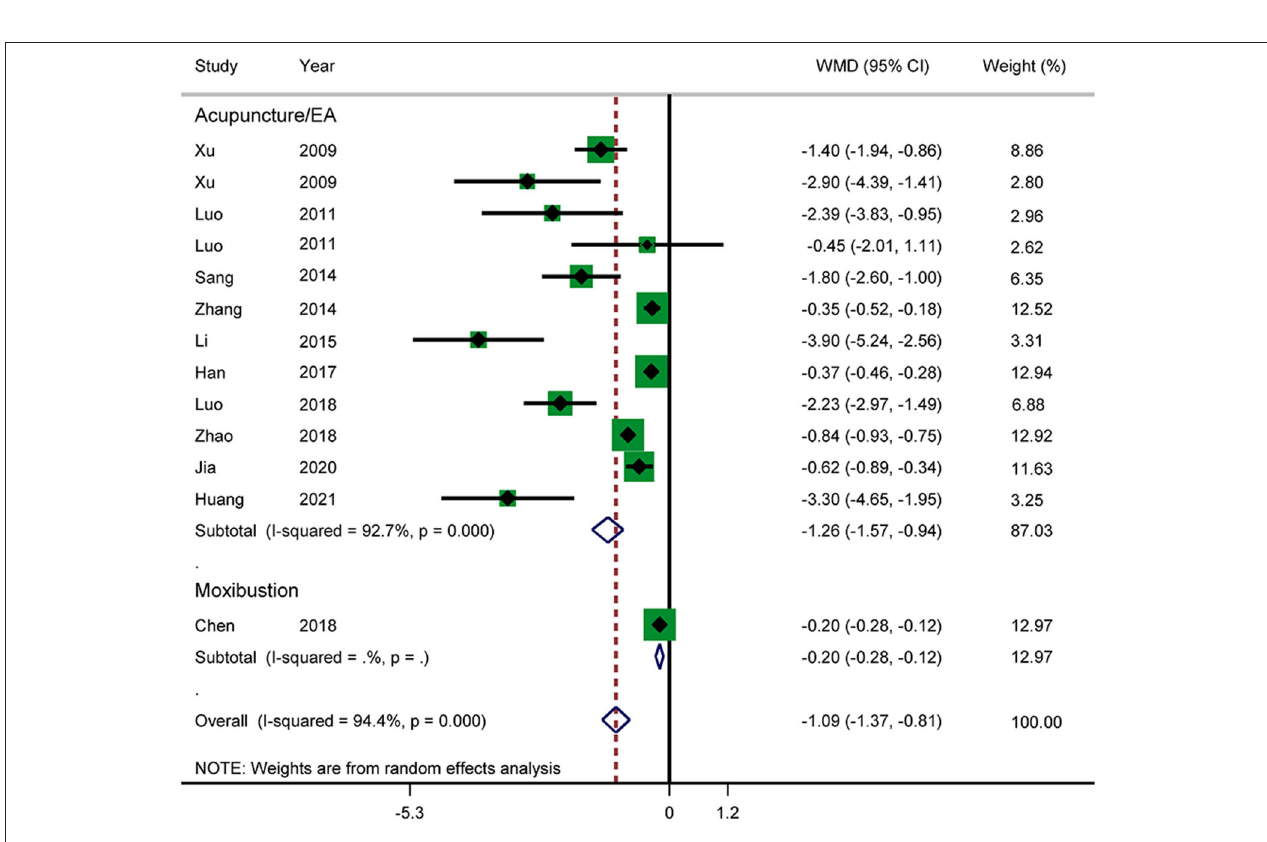
FIGURE 8 | T Meta-analysis of time until recovery of bowel